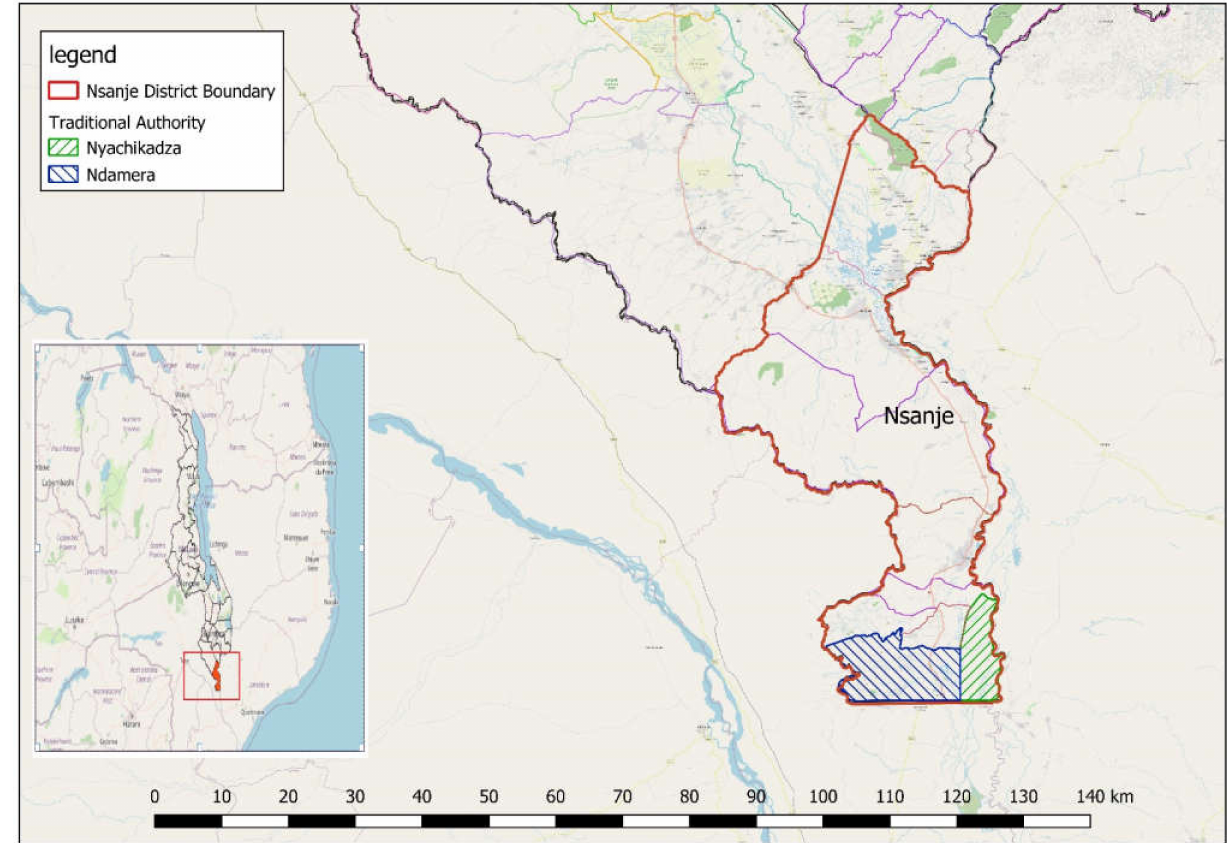
Figure 2. Location of traditional authorities Ndamera and Nyachikadza in Nsanje district of Malawi. The district is subdivided into nine Traditional Authorities, two of which are TA Nyachikadza (lowland) and TA Ndamera (upland). TA Nyachikadza is home to over 1000 households, which are located across 9 group villages (GVs). The community is affected by frequent flooding. When flood waters come, residents of TA Nyachikadza